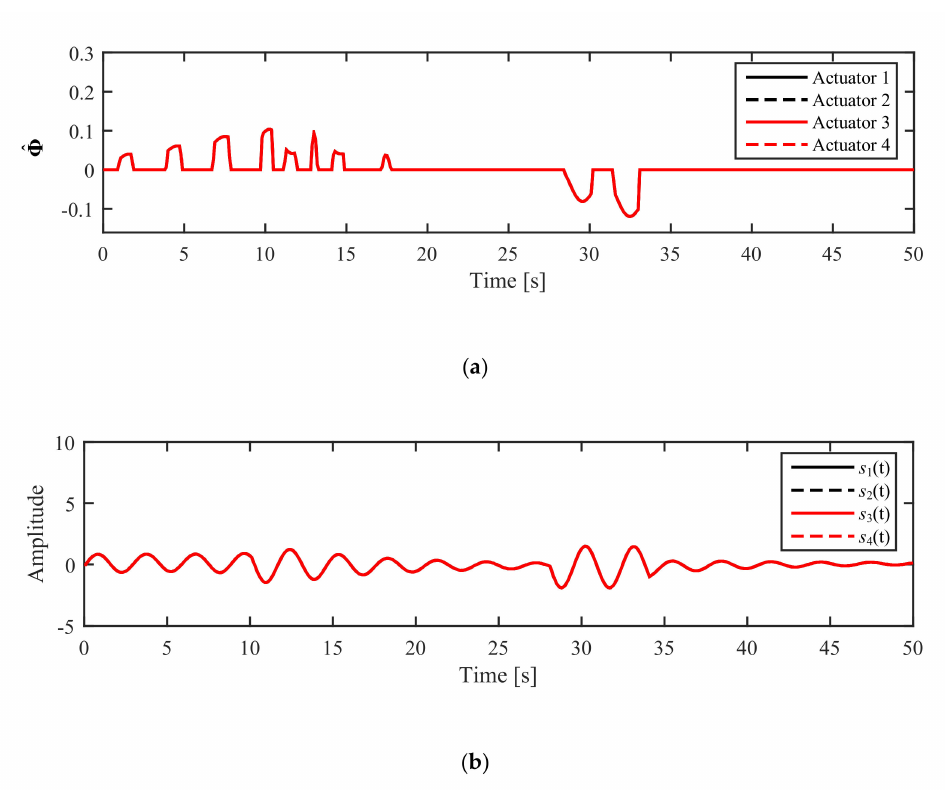
Figure 9. The performance of the proposed controller: ( a ) Updating switching gains of the ASTSMC- TDE (ASMC term); ( b ) Sliding manifold variables.